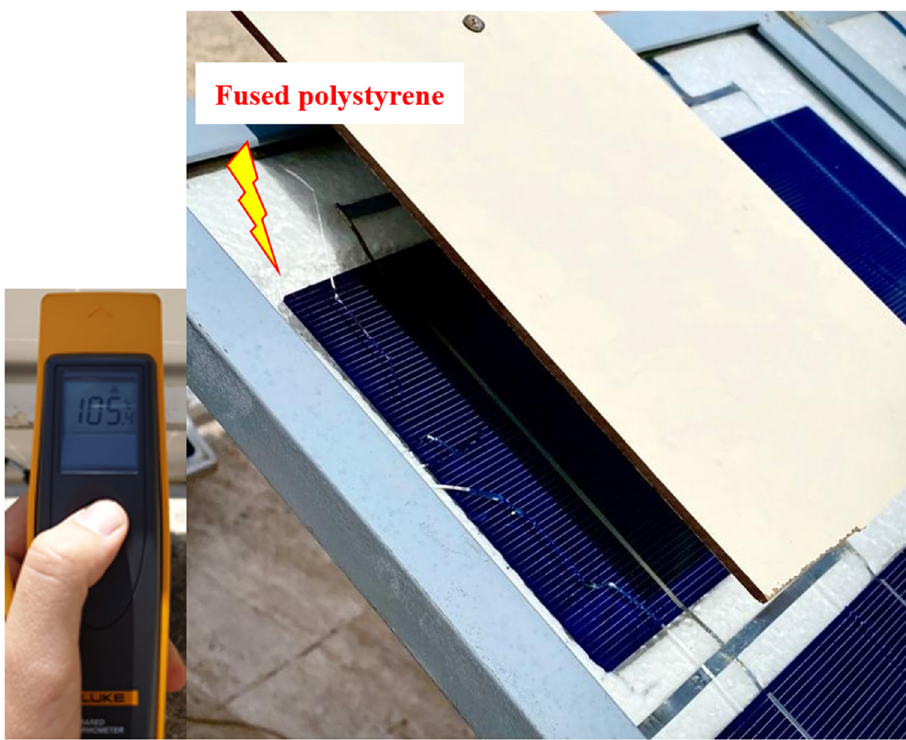
Figure 11. Some damage on the homemade submodule, when only a single PV cell has been partially shaded, and the bypass diode of the submodule intervened.